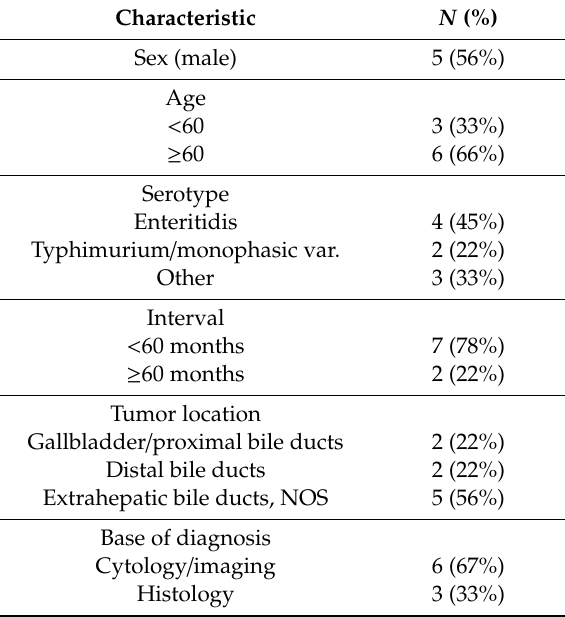
Table 3. Baseline characteristics of patients with Salmonella spp. infection and biliary tract